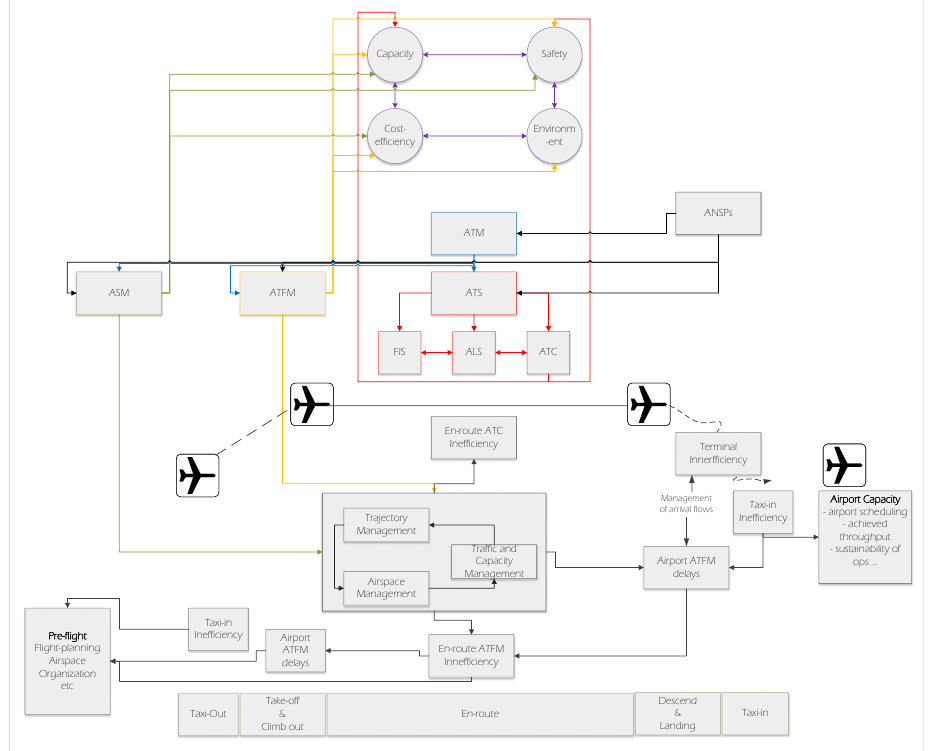
Figure 1. Conceptual Framework for ATM-related quality of